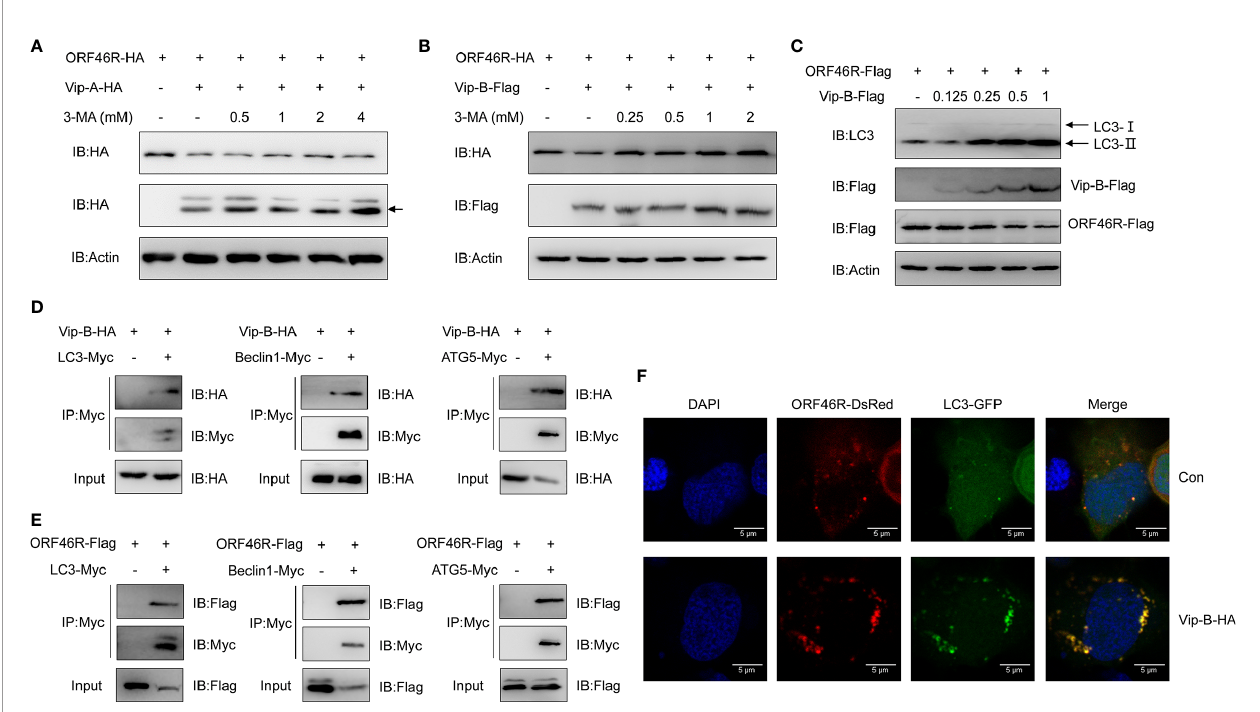
FIGURE 8 | Cg Viperin-B mediates degradation of Ca HV ORF46R via an autophagic pathway. (A, B) Effects of 3-MA on Cg Viperin-A- (A) or Cg Viperin-B-mediated (B) destabilization of ORF46R. CAB cells were transfected with the indicated expression vectors (2 m g/well) and treated with DMSO or 3-MA (0.5, 1, 2, or 4 mM in A and 0.25, 0.5, 1, or 2 mM in B) for 6 h at 18 h post-transfection. Then, the WCL were subjected to western blot analysis with the indicated Abs. (C) Effects of Cg Viperin-B on the conversion of LC3B-I to LC3B-II. CAB cells were transfected with increasing amounts of Cg Viperin-B-Flag (0.125, 0.25, 0.5, and 1 m g), analyzed by western blot analysis with the indicated Abs. (D, E) Co-IP of Vip-B-HA (D) or ORF46R-Flag (E) with LC3-Myc, Beclin1-Myc, and ATG5-Myc in HEK 293T cells transfected with the indicated plasmids. Anti-Myc Ab was used for Co-IP. (F) Subcellular colocalization of ORF46R and Cg Viperin-B with LC3-DsRed. CAB cells were plated onto coverslips in six-well plates and co-transfected with the indicated plasmids. After 24 h, the cells were fi xed and observed under confocal microscopy. Nuclear was stained with DAPI. Scale bars = 5 m